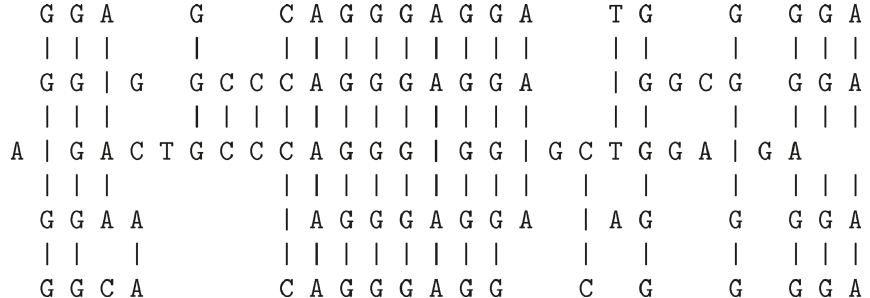
Figure 2: A “good” multiple sequence alignment amongst five DNA sequences (reproduced from Figure 3.1 in [5], with